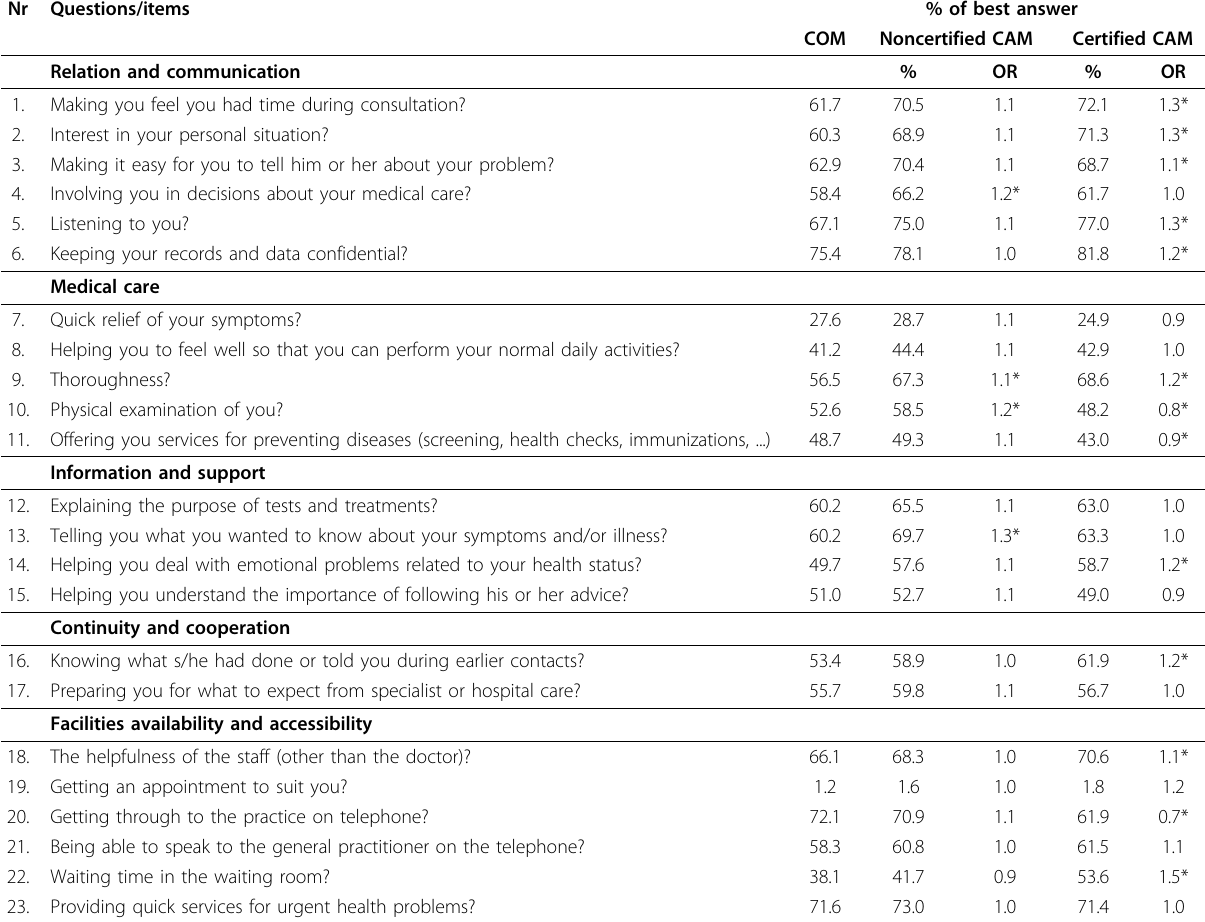
Table 5 Patient evaluation of COM and CAM, EUROPEP